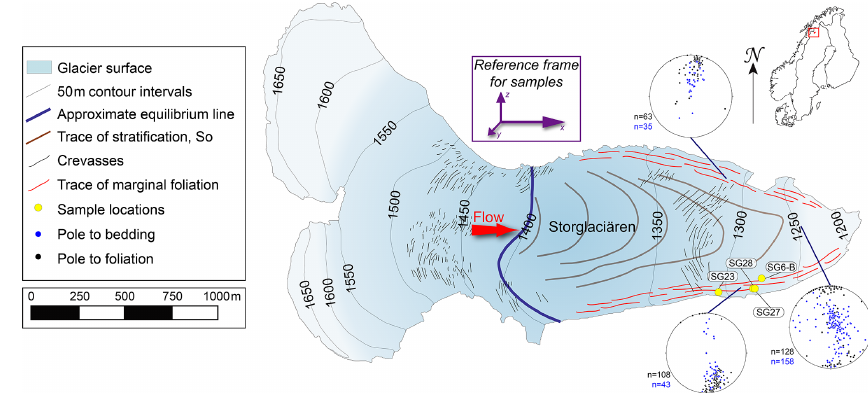
Figure 4. Simplified map of Storglaciären highlighting the traces of structural elements and orientations of foliation and bedding for the north margin, south margin and center of the glacier in the ablation zone. Locations of samples SG6-B, SG23, SG27 and SG28 are labeled. The orientation diagrams of planar fabric elements (stratification and foliation) are in geographic coordinates. The sample reference frame for the remainder of the paper is represented, where x is the flow or shear direction, y is the vorticity axis, and z is